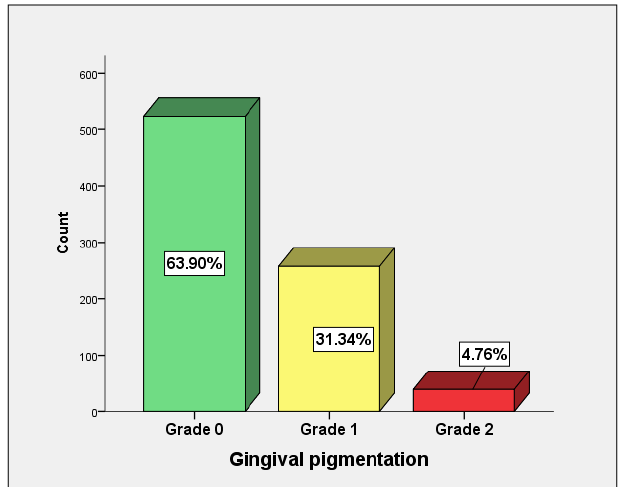
Figure. 3: Area of Pigmentation among participants